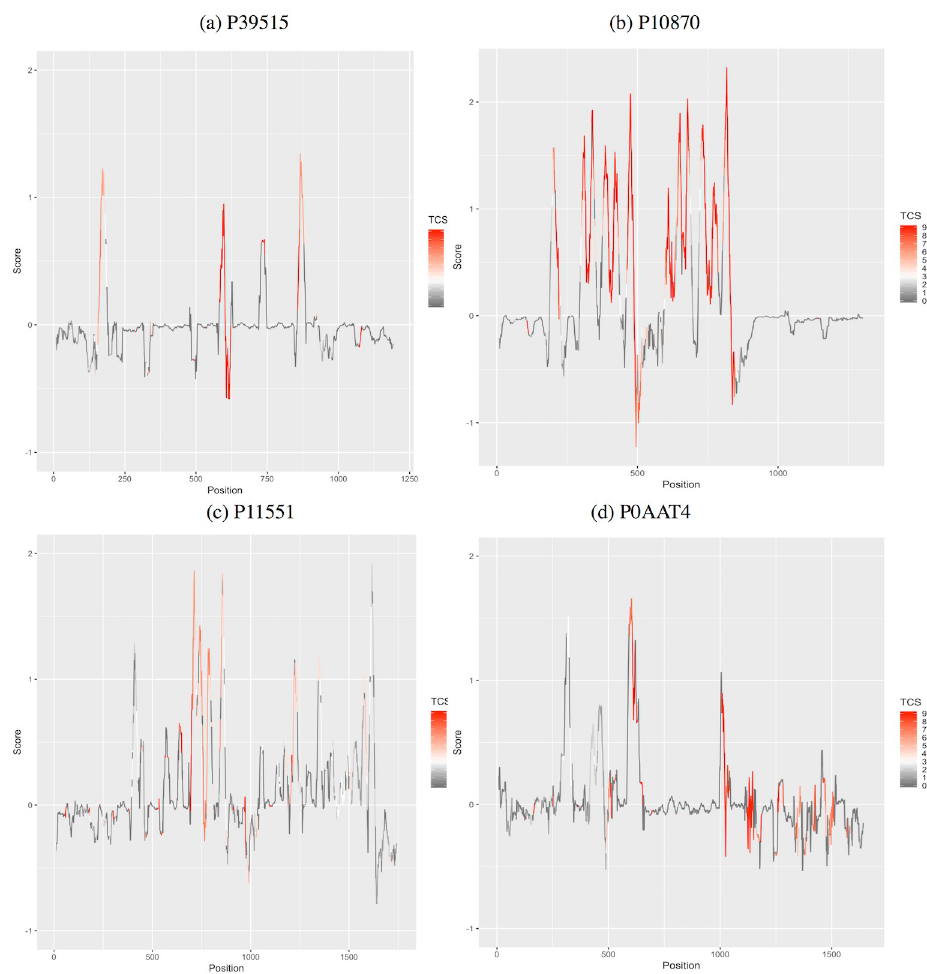
TCS score of at least 4 (shades of red), and filters out the other columns (gray and white). In (a) P39515 contains 158 residues, and the alignment of P39515 with other homologous sequences has 1203 columns, only 128 of them are informative (highlighted in shades of red). In (b) P10870 contains 884 residues, and the alignment of P10870 with other homologous sequences has 1312 columns, only 402 of them are informative. In (c) P11551 contains 438 residues, and the alignment of P11551 with other homologous sequences has 1753 columns, only 343 of them are informative. In (d) P0AAT4 contains 415 residues, and the alignment of P0AAT4 with other homologous sequences has 1653 columns, only 274 of them are